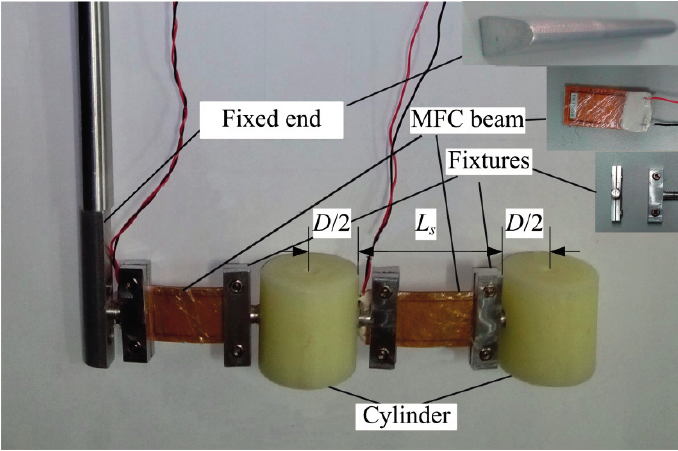
Figure 3. Experimental prototype of the piezoelectric energy